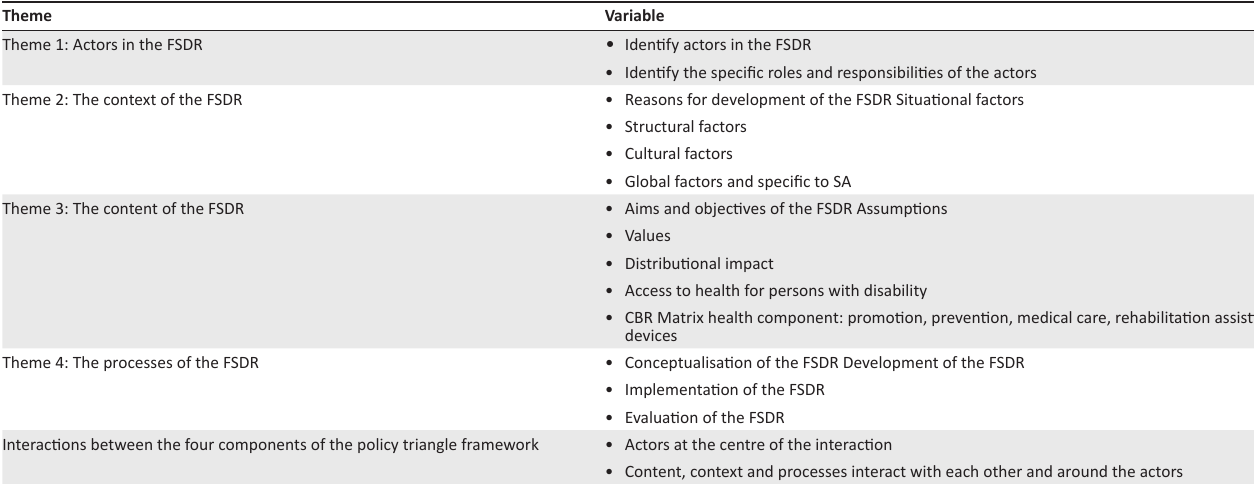
TABLE 1-A1: Document review guide.